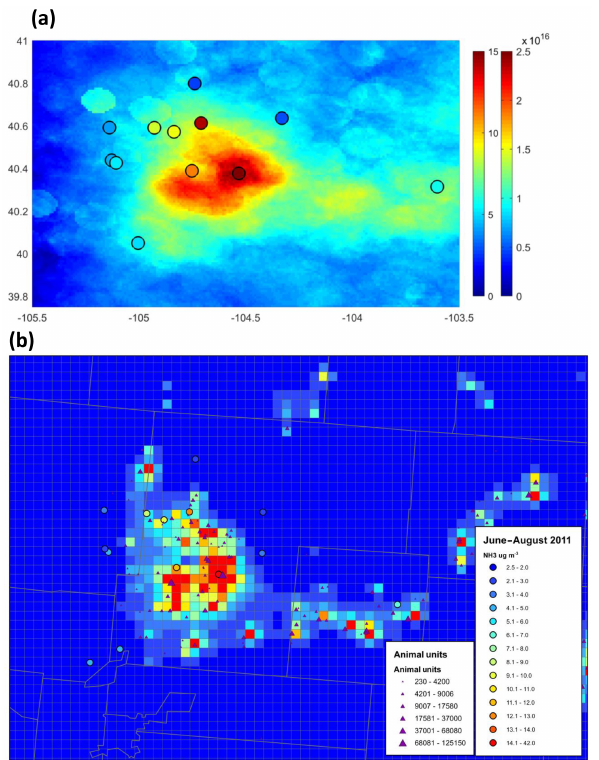
Figure 6. Comparison of surface NH 3 concentrations with IASI satellite retrievals and CAMx model simulations. (a) Radiello passive sampler surface NH 3 concentrations (µgm − 3 , left color bar) plotted on top of IASI-NH 3 satellite column retrievals (molec.cm − 2 , right color bar), both averaged for the summers of 4 years (2012–2015). The BAO site was only sampled in situ in the summer of 2012. (b) Comparison of measured and modeled NH 3 concentrations in the summer of 2011. The circles correspond to concentrations measured; these are superimposed on the CAMx modeled NH 3 concentration field. Animal units are indicated by the